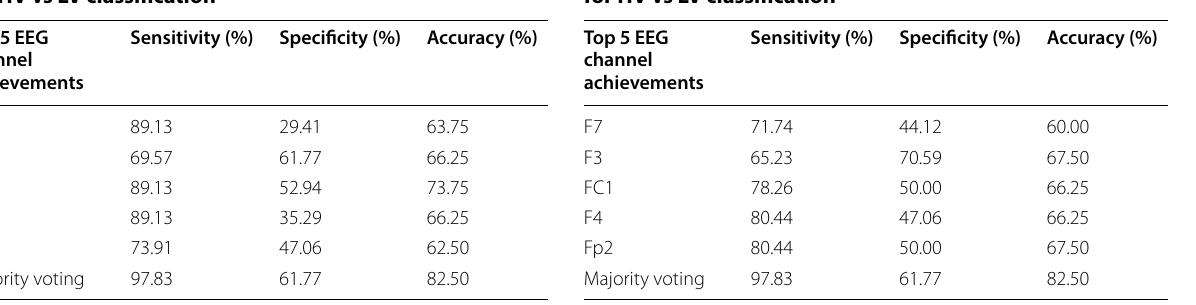
Table 5 Top 5 EEG channel achievements on delta